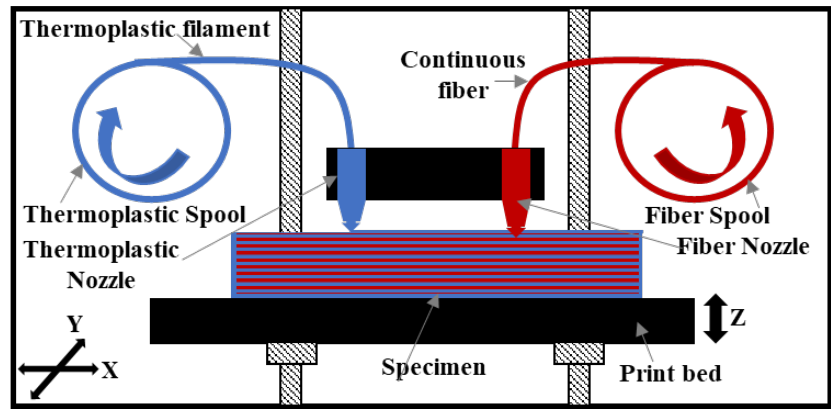
Figure 1. Schematic of the 3D-printing process.